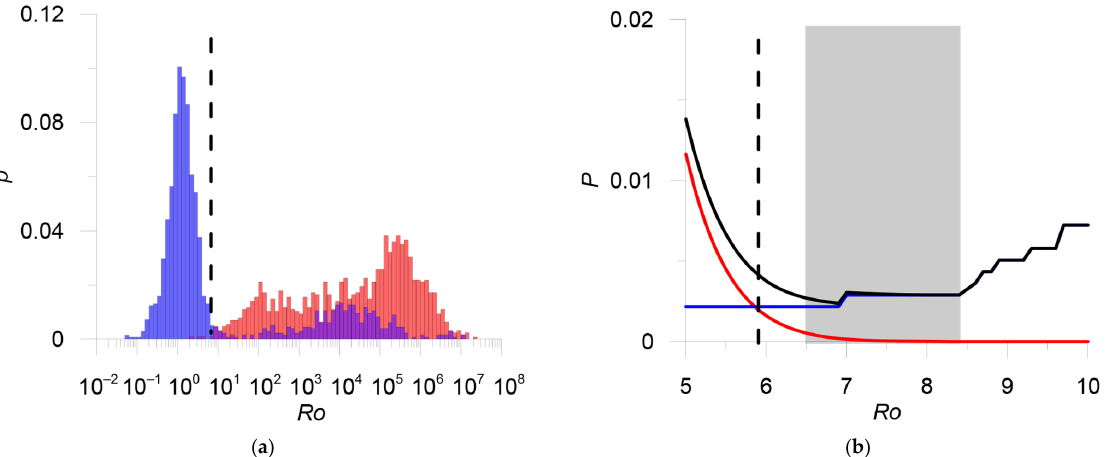
Figure 11. ( a ) Comparison of the distribution of the metric for the CORE/RUS_ISC pairs (blue histogram) and the same metric for the CORE/CORE earthquakes (red histogram). ( b ) Threshold optimization: the red line is the probability of missing a duplicate in the model with metric (1), the blue line is the probability of a false duplicate, the black line is the total probability of errors of the first and second kind, the dashed line Ro = 5.9 corresponds to an equal number of errors of the first and second kind (number of false duplicates is equal to the number of missed duplicates), the estimate of the total number of errors is approximately 0.4%, and the gray bar shows the range of values of the metric Ro = 6.5 ÷ 8.4, minimizing the total number of errors (approximately